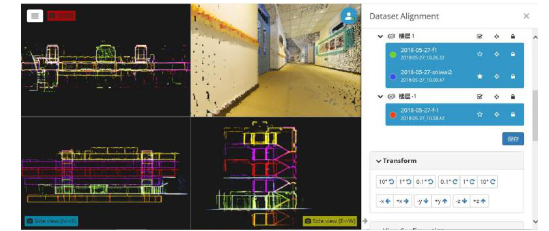
Figure 3. Relative registration of data unit